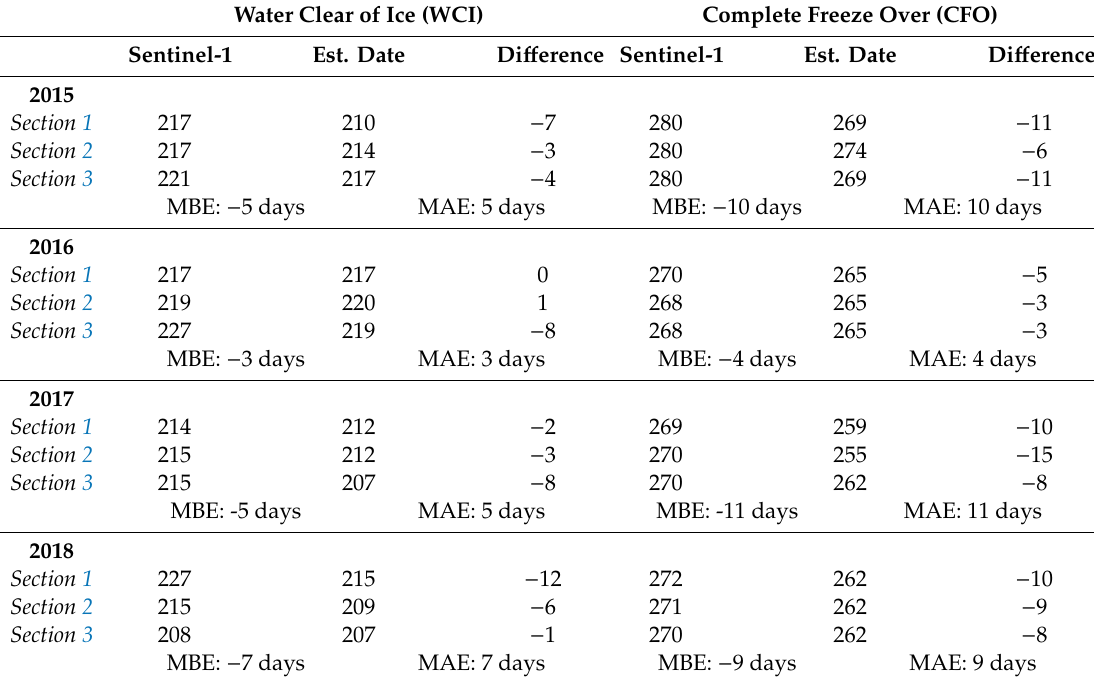
Table 3. Mean bias and mean absolute errors for the determination of overall lake ice phenology event dates (water clear of ice (WCI) and complete freeze over (CFO)) using the first di ff erence method.